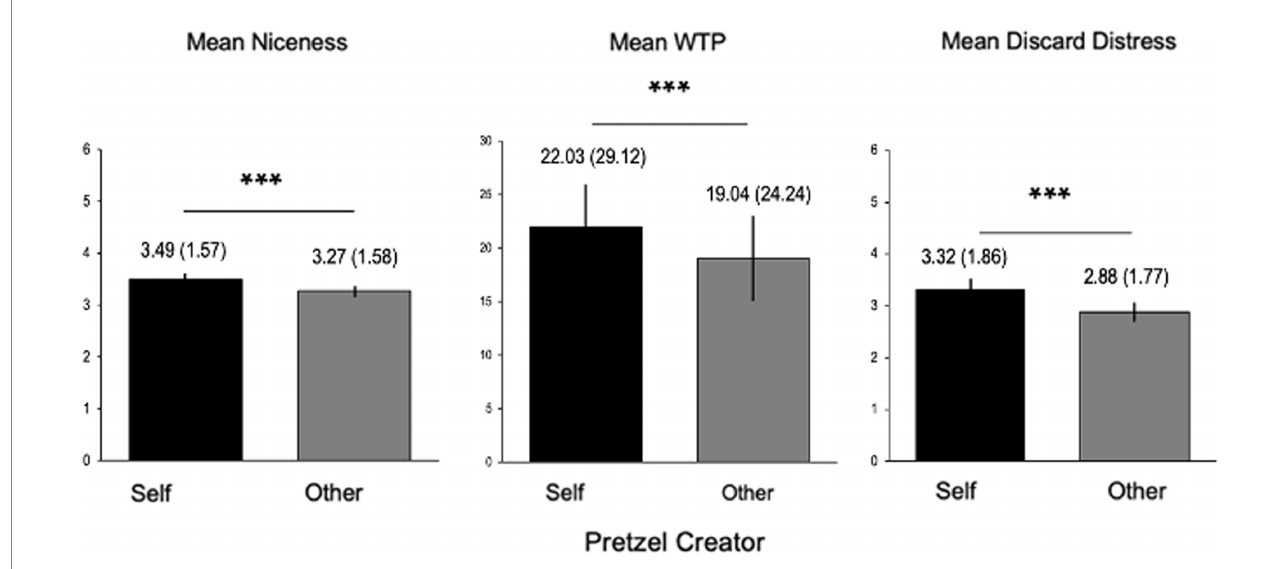
FIGURE 3 Self > Other rating overvaluation. Within-subject ratings on all dimensions increased for Self > Other. *** p < 0.001. WTP, Willingness to pay, in